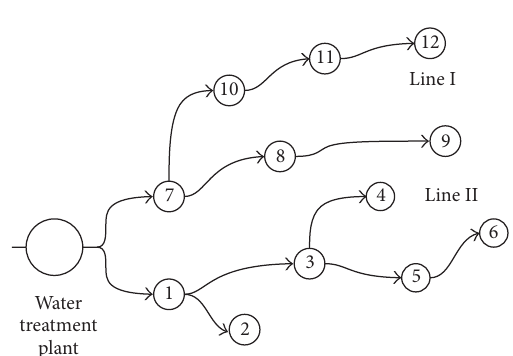
Figure 1: The schematic diagram for the minimal spanning trees between each spot in need of water and the water plant within one